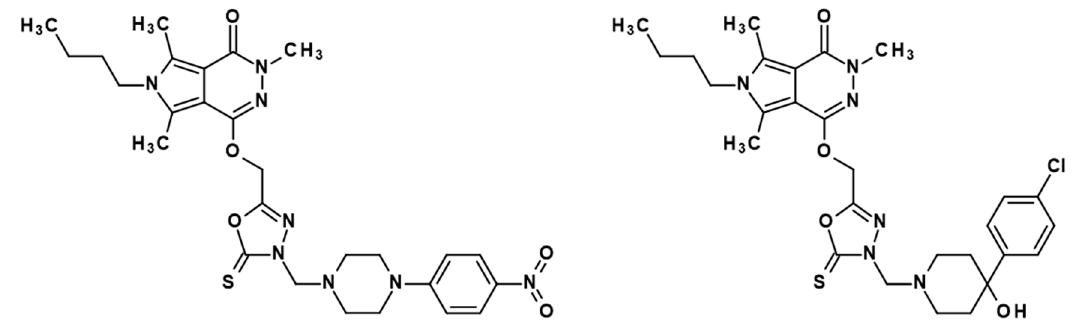
Figure 1. Chemical structures of investigated compounds 10b (left) and 13b (right).